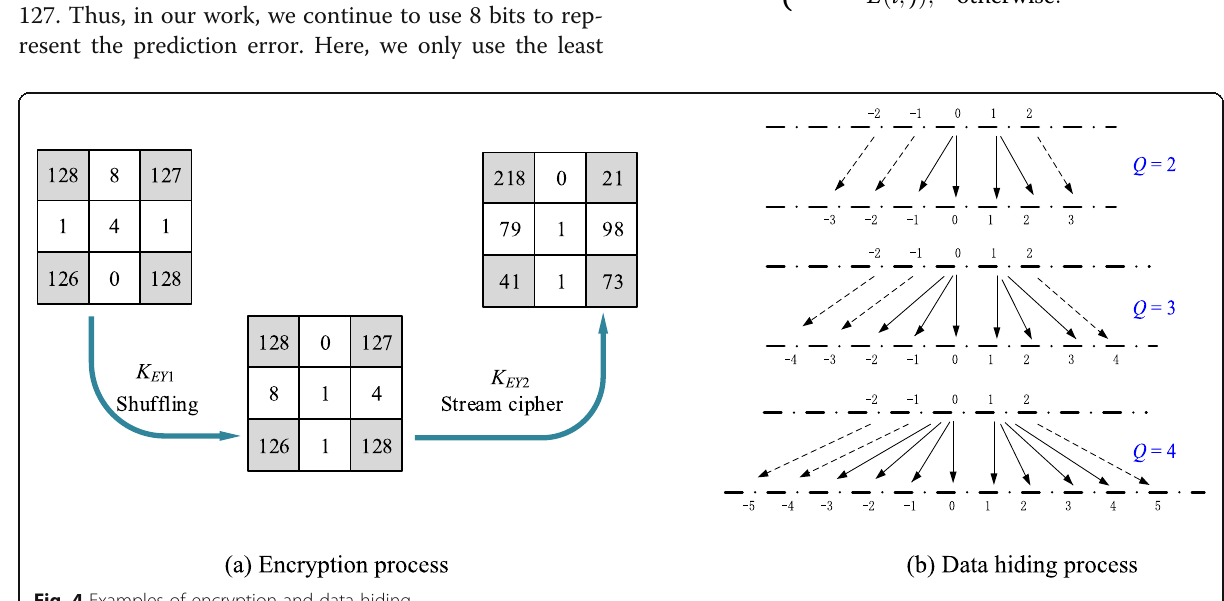
Fig. 4 Examples of encryption and data